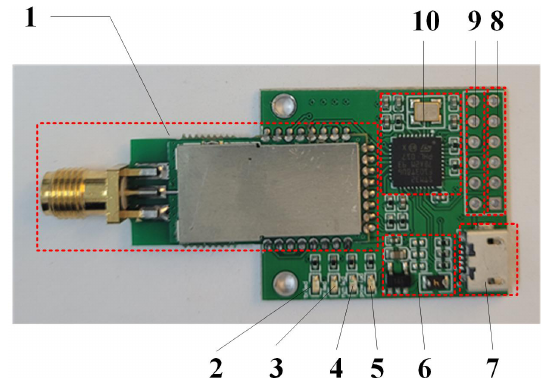
Figure 3. Positioning module development board. 1 – DW1000 chip; 2, 3 – DW1000-RX LED indicator (blue); 4 – status indica- tor (yellow); 5 – power indicator (red); 6 – power module; 7 –